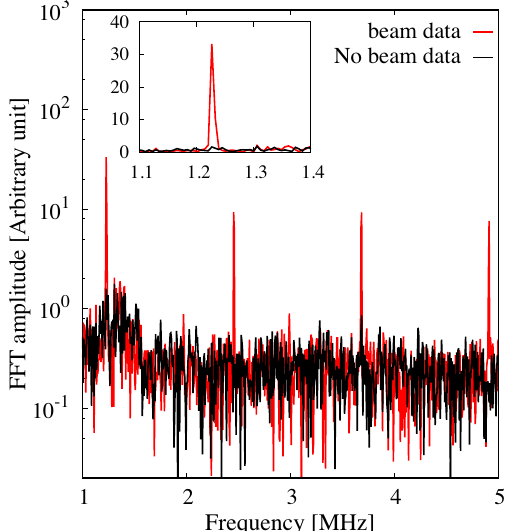
FIG. 10. FFT of the time domain data with the waste beam and no beam. The FFT amplitude corresponding to the chopping frequency and higher rf multiples clearly shows the signal of the waste beam. An expanded view of the FFT spectra near the fundamental frequency region is shown in the inset.